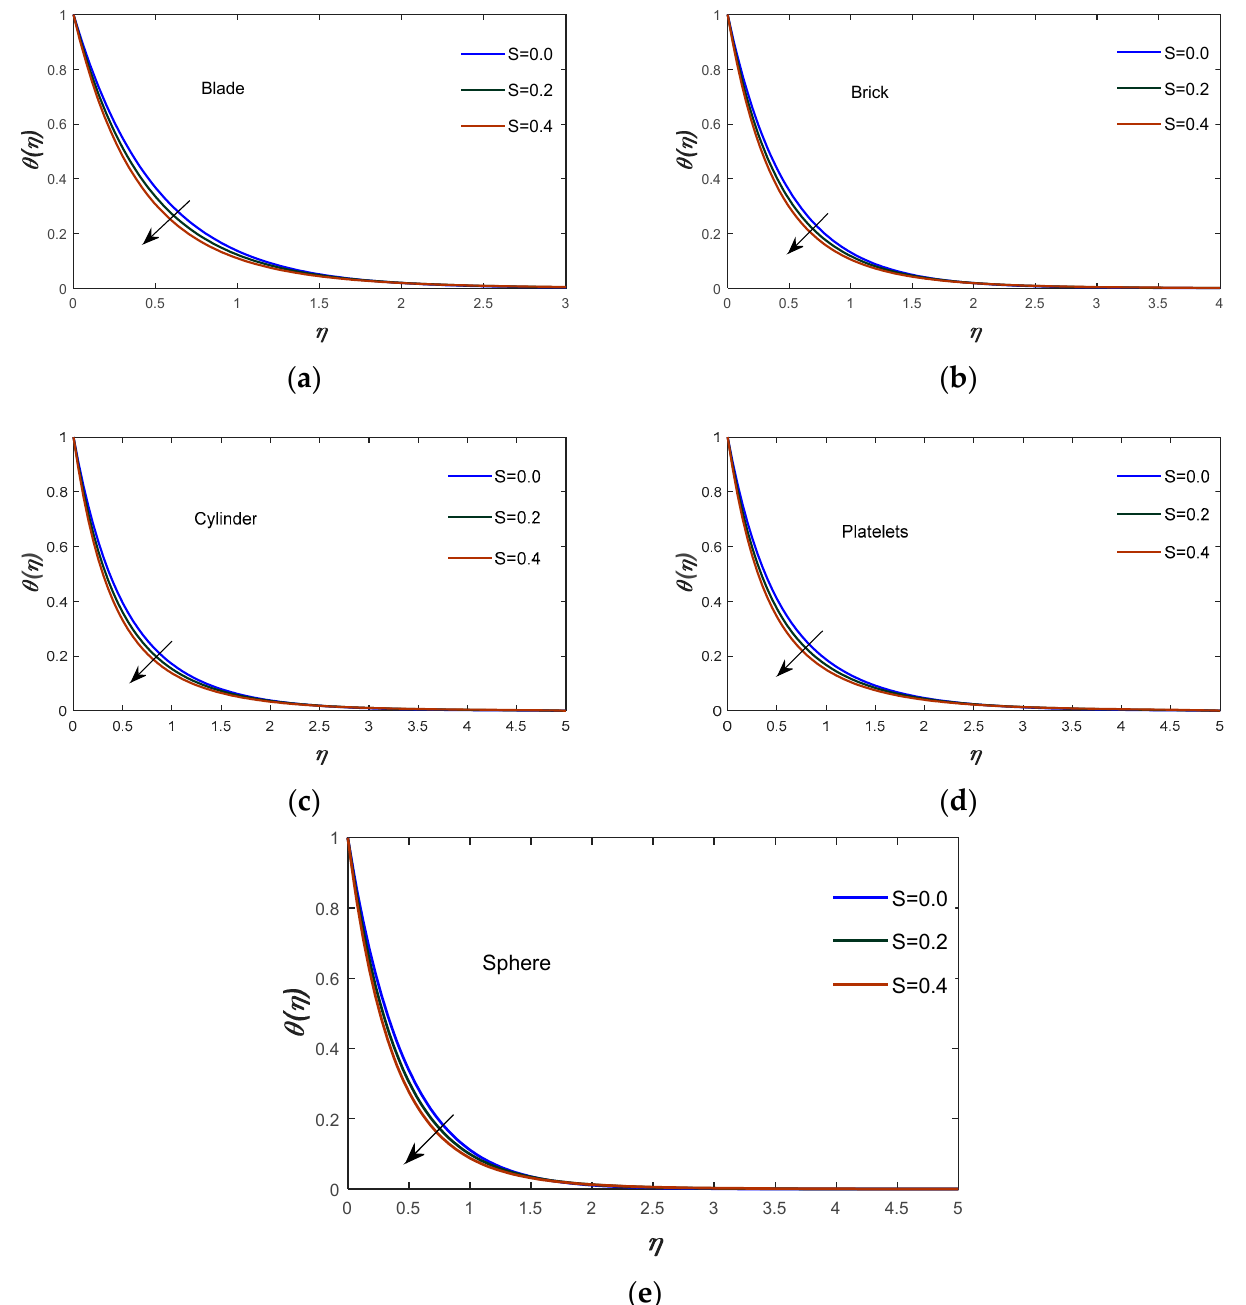
Figure 6. ( a – e ). Impact of 𝑆 on 𝜃(𝜂) by using various shapes factors of nanoparticles for fixed 𝑀 = 1.0, 𝑃𝑟 = 6.0, 𝑘 = 0.5, 𝐸𝑐 = 1.0, 𝜑 = 0.02 .